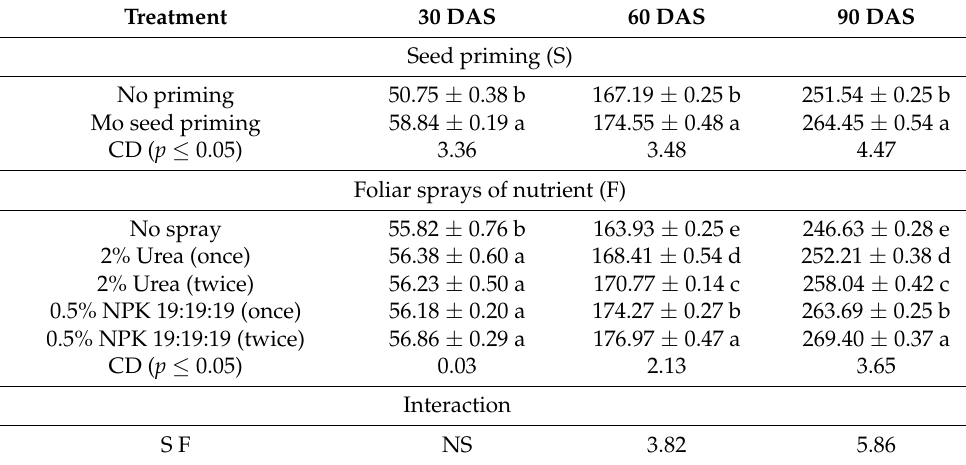
Table 3. Dry matter accumulation (g m − 2 ) in grass pea at different growth stages (pooled means of 2 years).